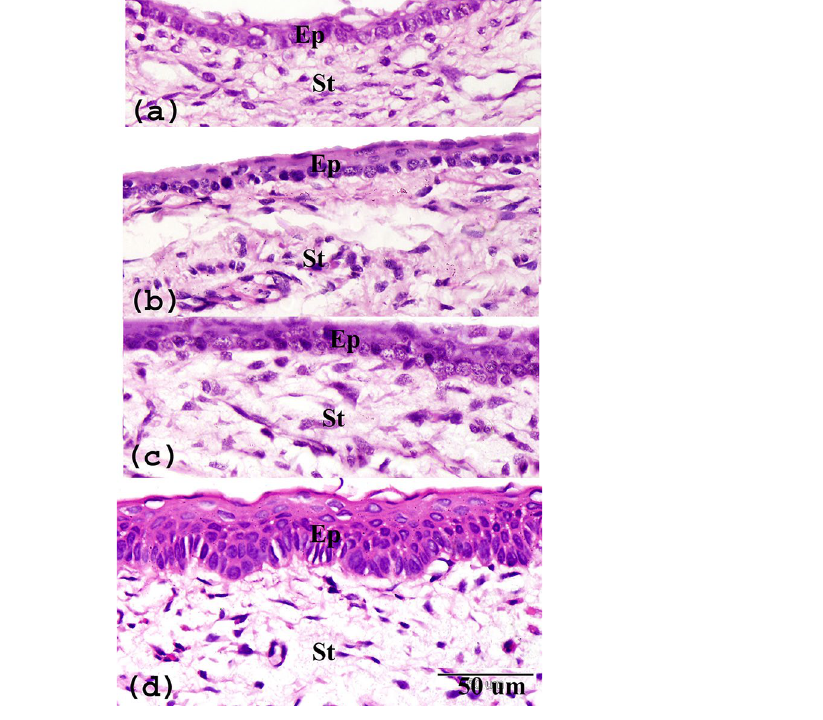
layers. ( c ) At PND15, increased to five to six layers, ( d ) At PND30, the thickness of limbal epithelium was highly differentiated and showed mature stratified squamous epithelium. Note epithelium (Ep) and stroma (St).